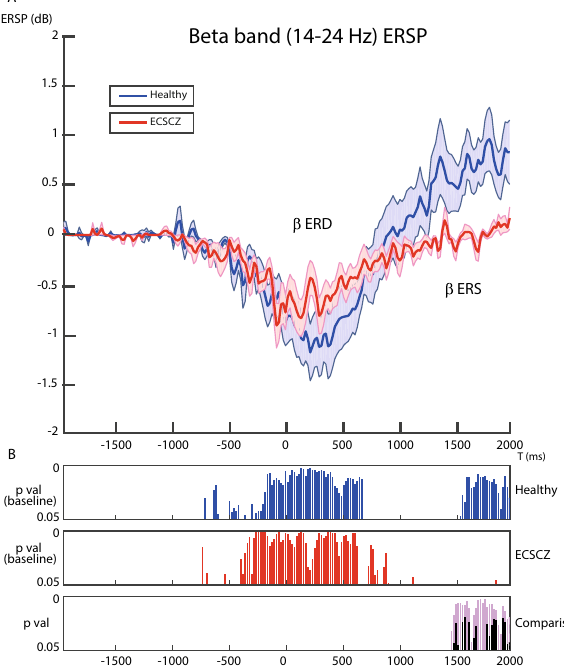
Figure 2. The post-movement event-related synchronization in the beta band is significantly reduced in patients. ( A ) shows the profile of the averaged event-related spectral perturbation (ERSP) for the beta band (14–24 Hz) over time for healthy controls (HC, blue line) and early-course Schizophrenia patients (ECSCZ, red line) calculated at electrodes C1-FC1. Standard errors of the mean are visualized in shaded colors. In ( B ) (top, mid), the ERSP in each time bin is compared with the baseline within each group (HC: blue bars; ECSCZ: red bars). In ( B ) (bottom) each time bin is compared between groups. Purple bars show time bins with significantly different ERSP between patients and healthy subjects ( p < 0.05, Wilcoxon rank-sum tests). Black bars show significantly different time bins after FDR correction. While both groups showed a similar movement-related desynchronization pattern (event-related desynchronization, ERD), patients’ post-movement rebound in beta frequencies (event-related synchronization, ERS) was significantly reduced in 27 consecutive time bins (1446 to 2000 ms), of which 17 survived after correcting for multiple comparisons.